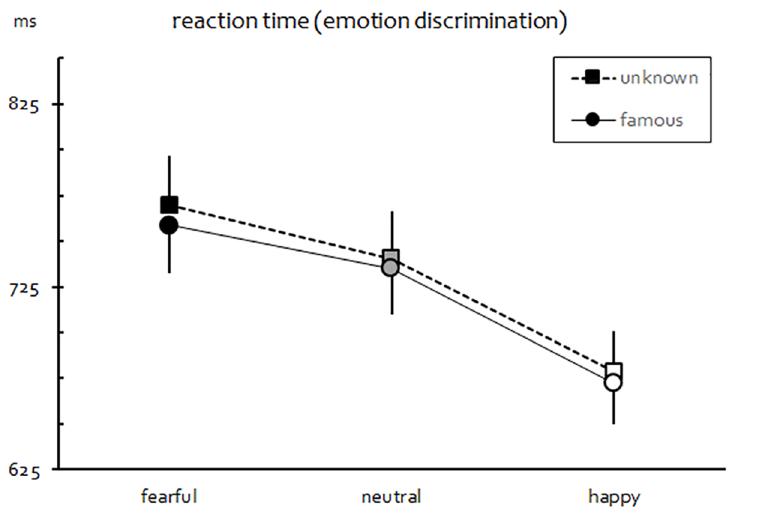
Fig 5. Mean RT in Exp. II. Error bars represent